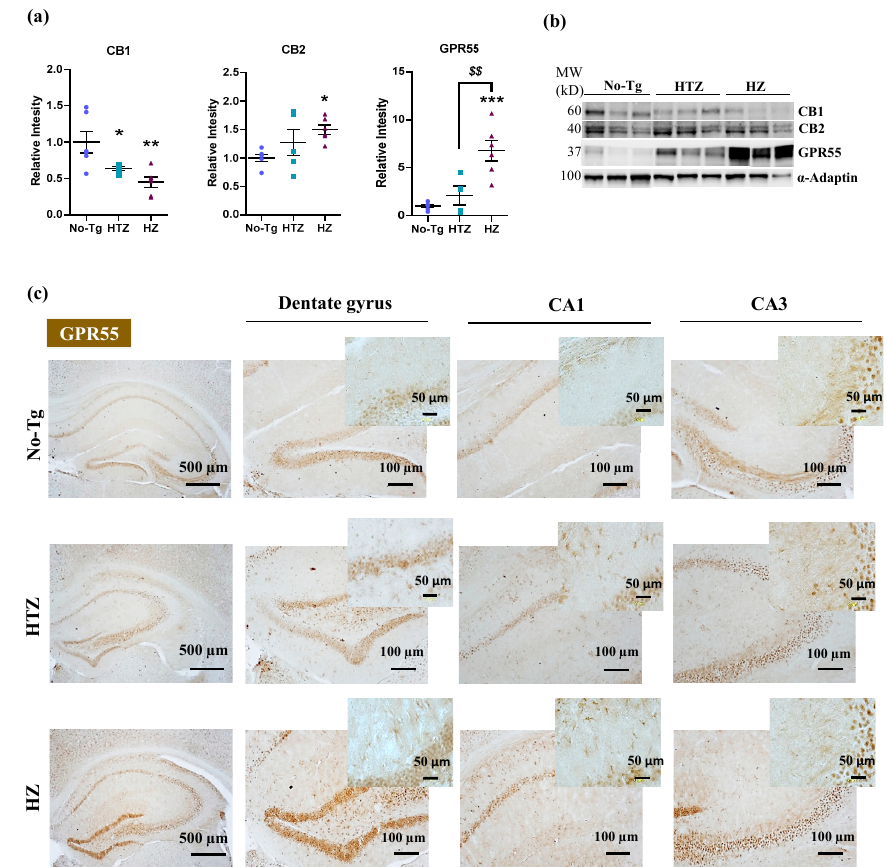
Figure 3. Effect of the genetic load of the disease on protein expression of the endocannabinoid system in a transgenic mouse model of Alzheimer’s disease (AD) (5xFAD). ( a ) Bar charts represent the quantification of Western blot membranes ( b ) after incubating with anti-cannabinoid receptor (CB1, CB2) and anti-G-protein-coupled receptor 55 (GPR55) antibodies and normalized with α -adaptin. We performed the Western blot analysis on hippocampus homogenates. The blots shown in ( b ) are a representation of all the bands (see Figures S2 and S3, Supplementary Materials, for additional information), resulting from three out of six independent samples (three out of five for the HTZ group). Molecular weights (MW) are indicated in kilodaltons (kDa). The corresponding expression of α -adaptin is shown as a loading control per lane. ( c ) The images show the representative GPR55 staining in the hippocampus, dentate gyrus, CA1, and CA3 of each group. One-way ANOVA and Tukey’s test were performed: (*) p < 0.05, (**) p < 0.01 and (***) p < 0.001 vs. No-Tg group; ($$) p < 0.01 between HTZ and 5xFAD group. Histograms represent the mean ± SEM ( n = 6) Scare bar = 500, 100 and 50 µ